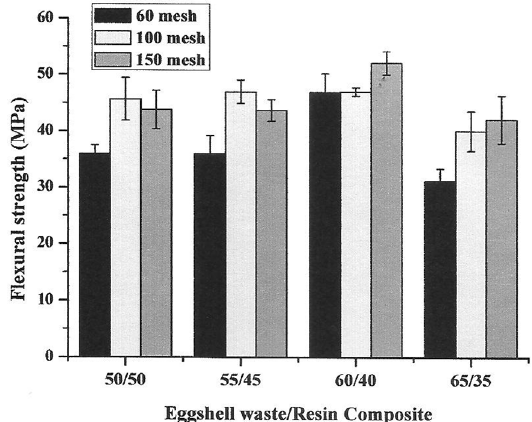
Figure 7. Flexural strength of the cured artificial rock specimens.